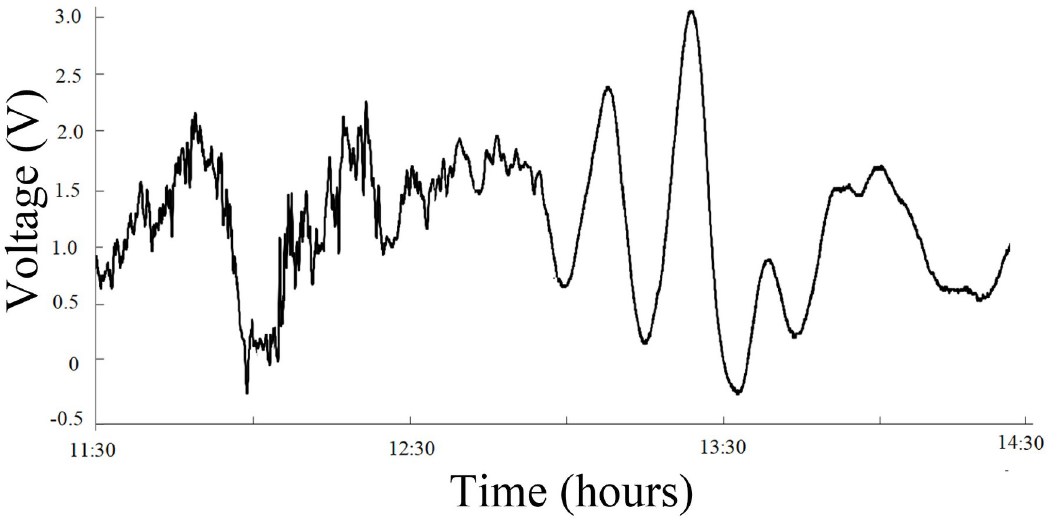
Fig 7. Anomalous infrasound signals on April 11, 2010.